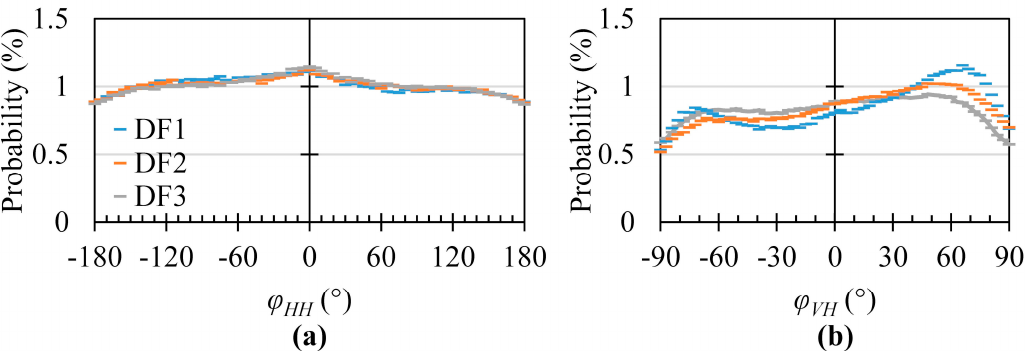
Figure 10. Probability distribution of the phase difference between ( a ) the two horizontal components ( 𝝋 𝑯𝑯 ) and ( b ) the vertical and horizontal component in the primary vibration direction ( 𝝋 𝑽𝑯 ).